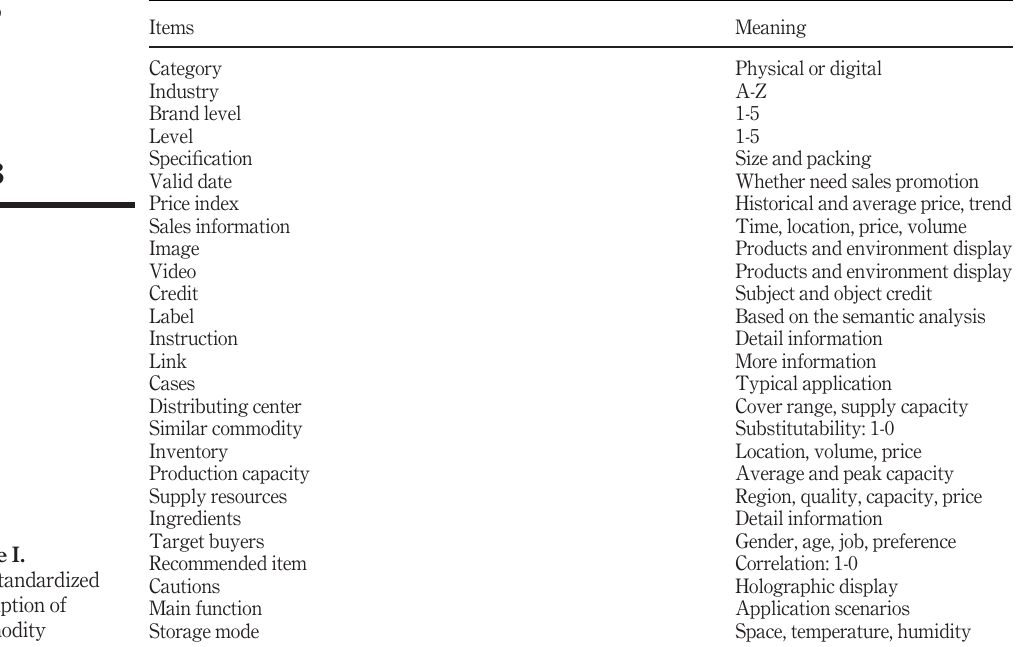
Table I. The standardized description